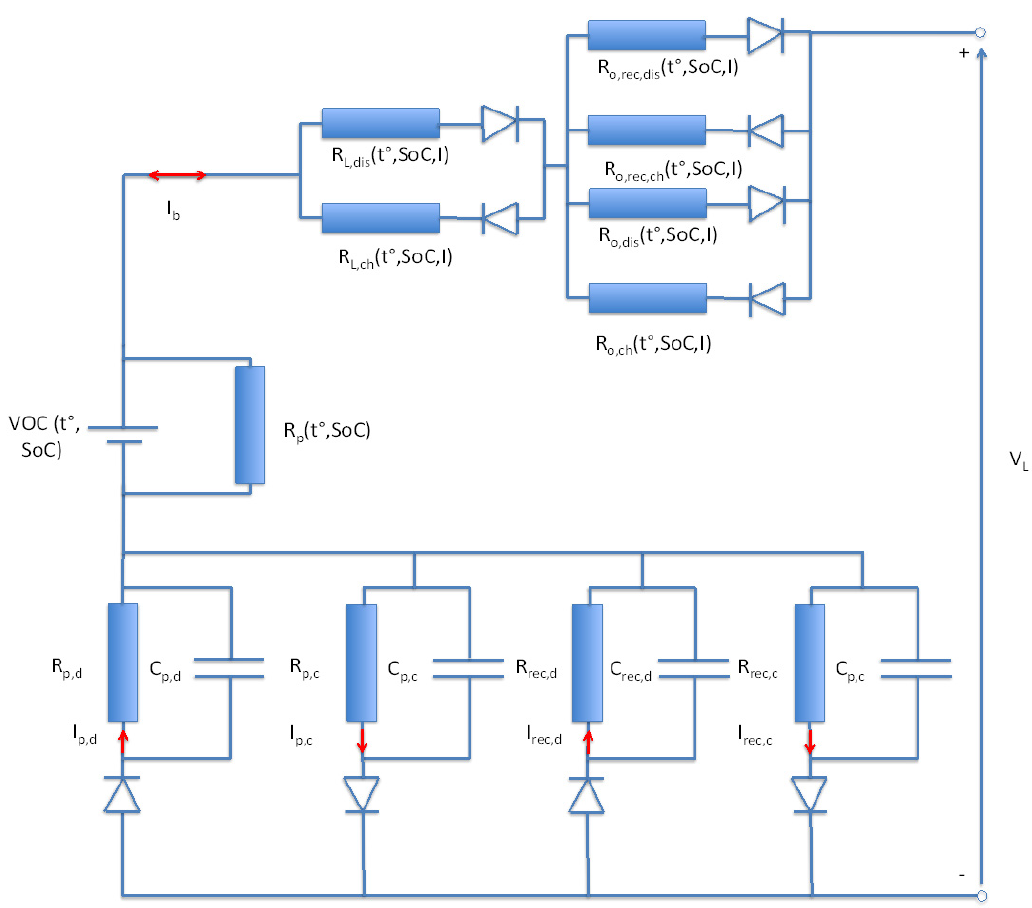
Figure 33. New lithium-ion battery